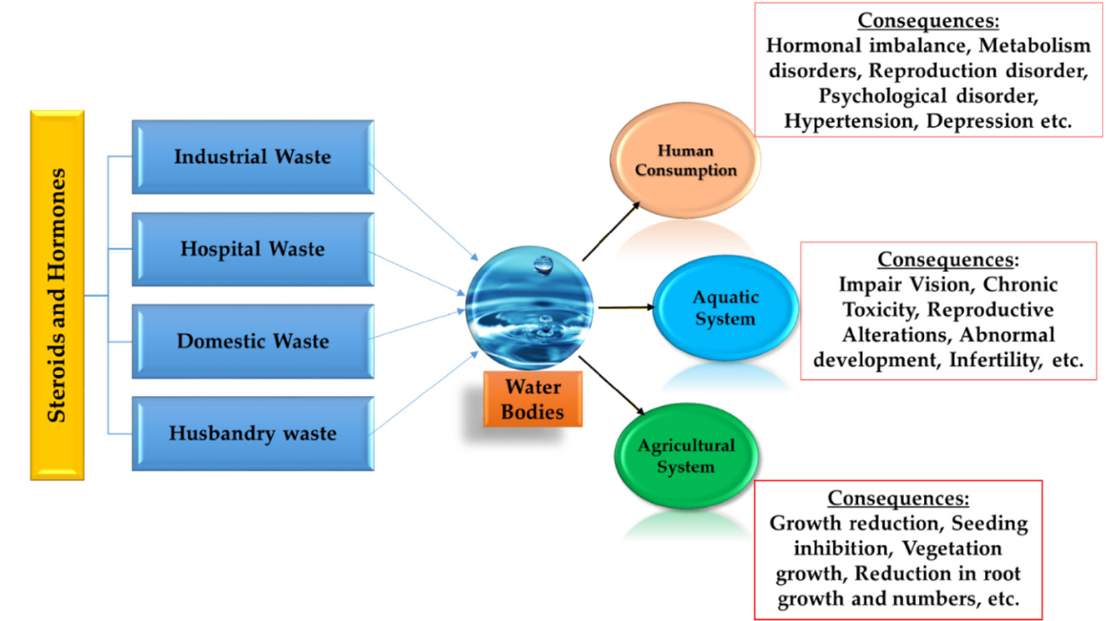
Figure 1. Schematic diagram of main sources and fates of steroids and hormones in human world, plants, and the aquatic environment [19–21].